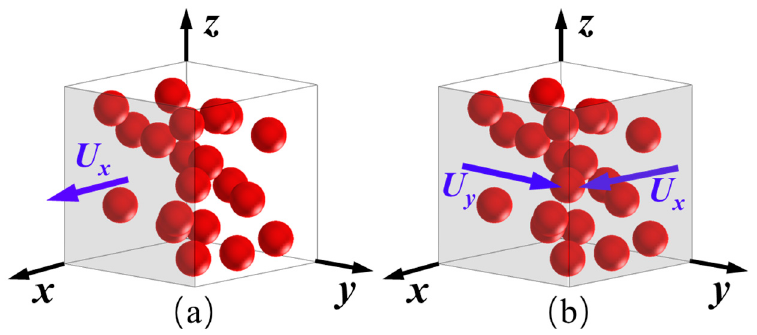
Figure 2. Boundary conditions of calculation model for mechanical anisotropy of composite: ( a ) nor- mal strain; ( b ) shear strain.